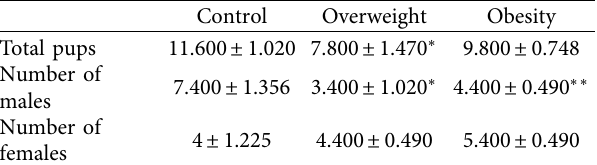
∗ Indicates significant differences between the control vs. overweight group. ∗∗ Indicates significant differences between the control vs. obesity group, P < 0 .